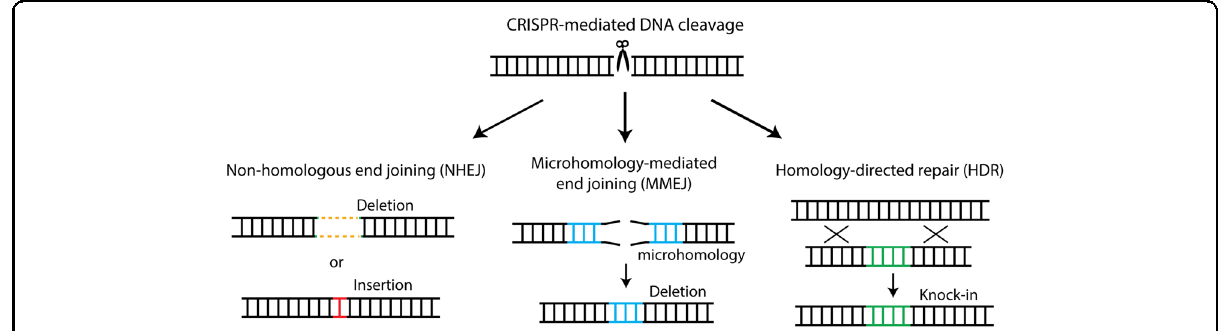
Fig. 1 Schematic of the cell ’ s own repair processes. They include the non-homologous end joining (NHEJ) pathway, the microhomology- mediated end joining (MMEJ) pathway, and the homology-directed repair (HDR)